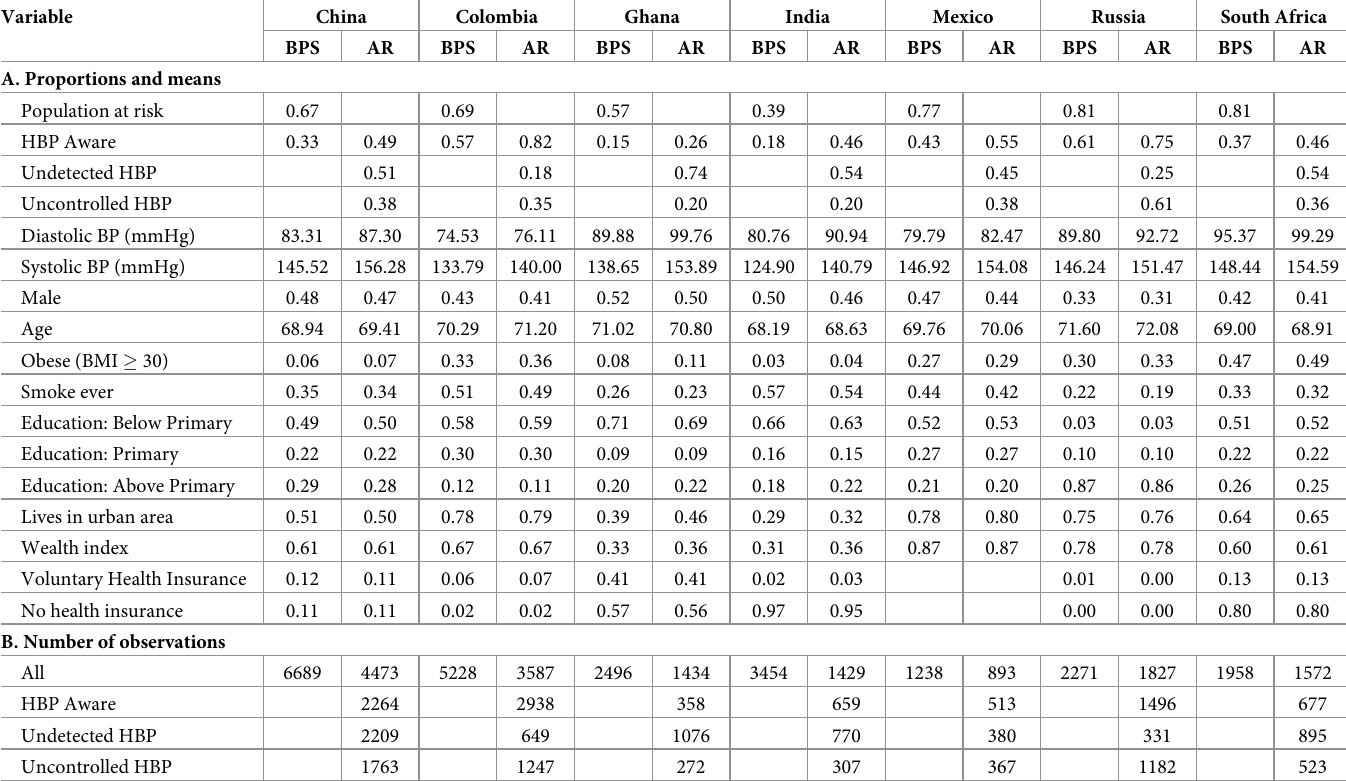
Table 1. Means by